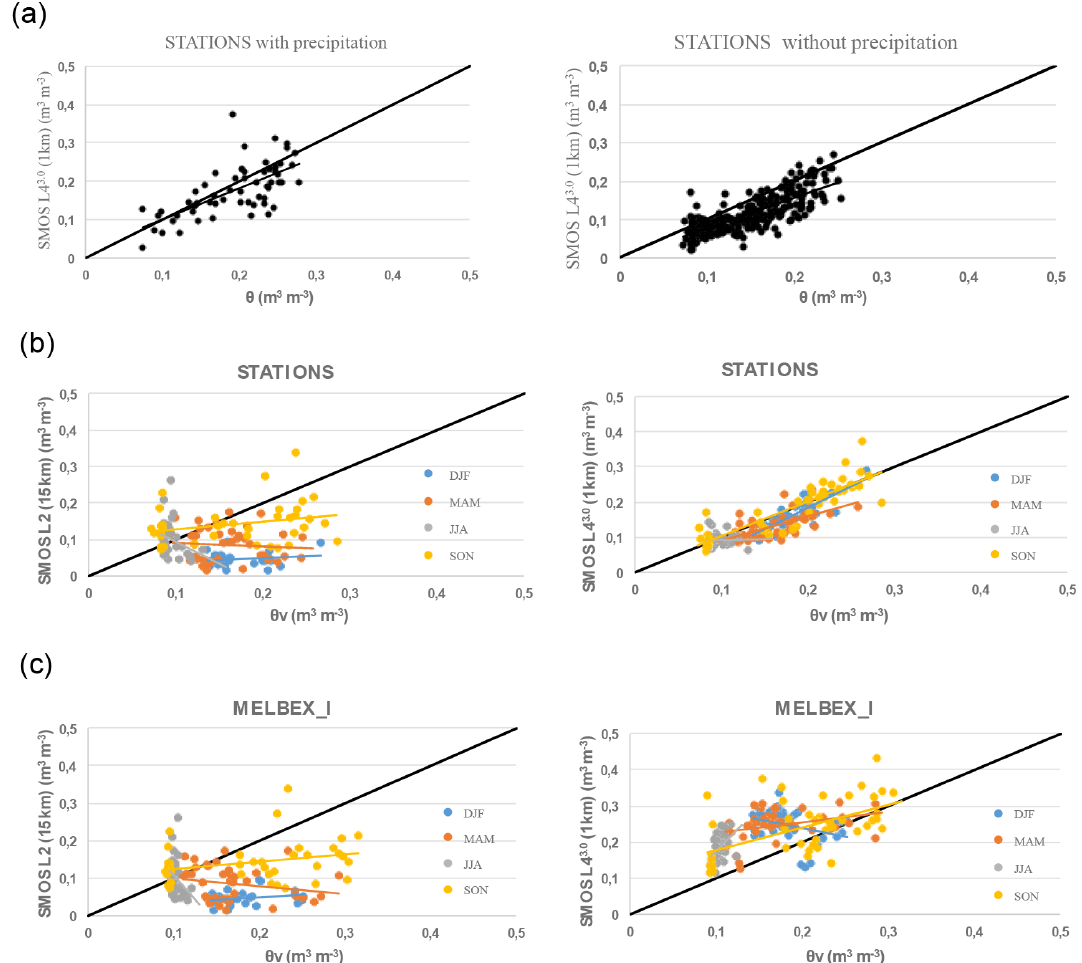
Figure 7. Results of the seasonal analysis for the hydrological year starting in December 2011. Scatter plots of (a) SMOS-L4 3 . 0 SSM (as- cending and descending orbits) versus averaged 10km × 10km in situ soil moisture measurements for days with precipitation (left) and for days without precipitation (right; <1mmd − 1 ). (b) SMOS-L2 and SMOS-L4 3 . 0 SSM (descending orbits) versus averaged 10km × 10km in situ soil moisture measurements. (c) SMOS-L2 and SMOS-L4 3 . 0 SSM (descending orbits) versus point-like ground measurements from MELBEX-I station, using the closest grid point. Segments are linear fit of seasonal data (3 months of data). Statistics for individual compar- isons at all stations are summarized in Table